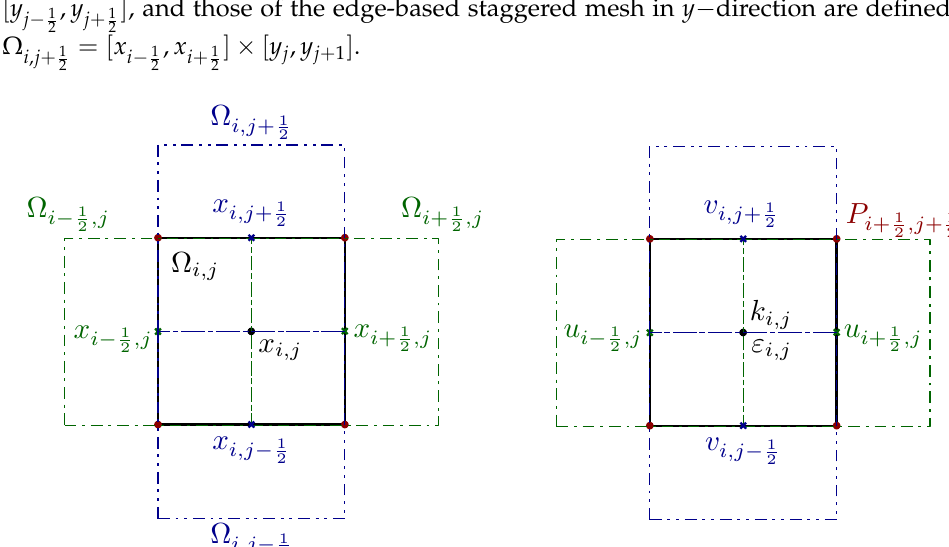
Figure 3. Sketch of the staggered Cartesian grids. The primal element is represented in black, the edge-based staggered dual elements in x -direction are in green dash-dotted lines and the edge-based staggered dual elements in y -direction are in blue dash-dotted-dotted lines. ( Left ): mesh notation. ( Right ): locations of the